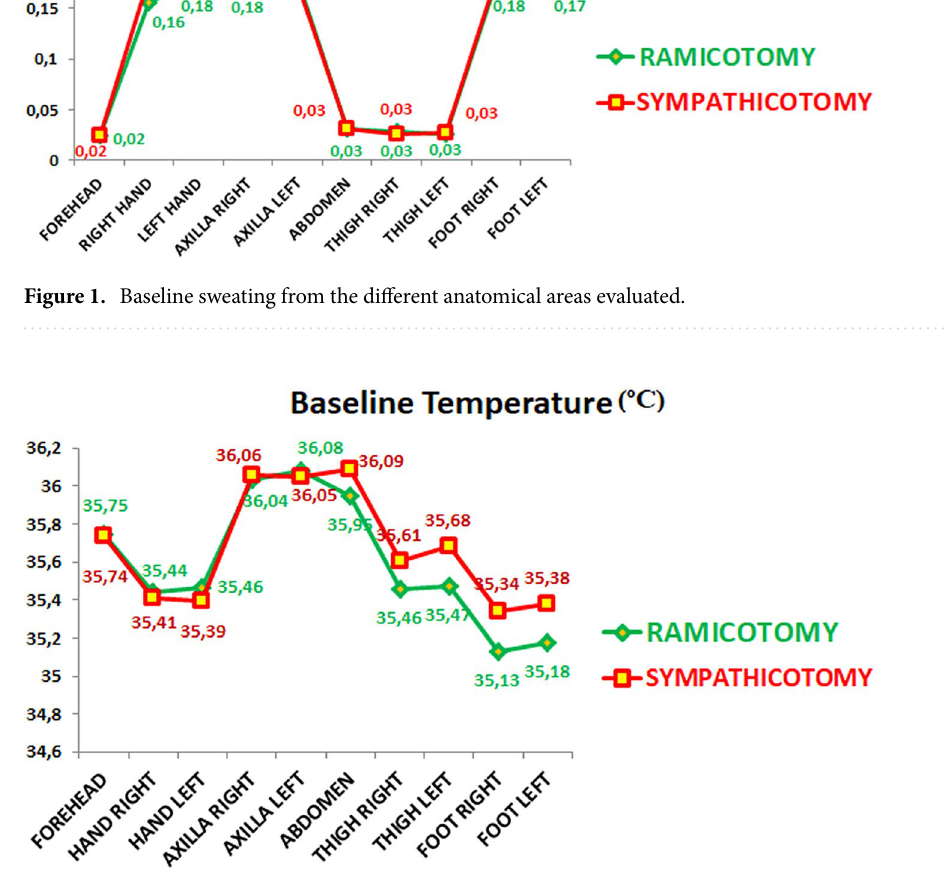
Figure 2. Baseline temperatures from the different anatomical areas